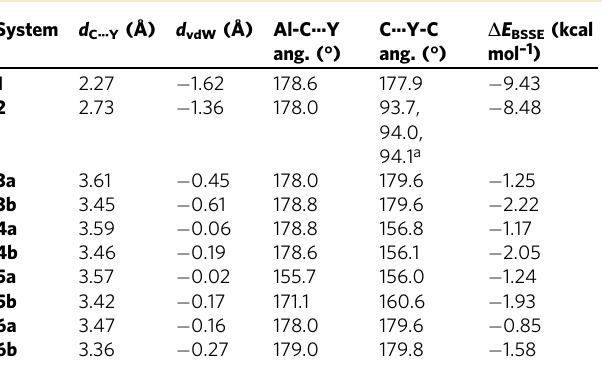
Table 1 M06-2X/def2-TZVPD interaction energies, absolute ( d C···Y ), and vdW-corrected ( d vdW ) interatomic distances and Al-C···Y and C···Y-C angles for optimized model adducts 1 –